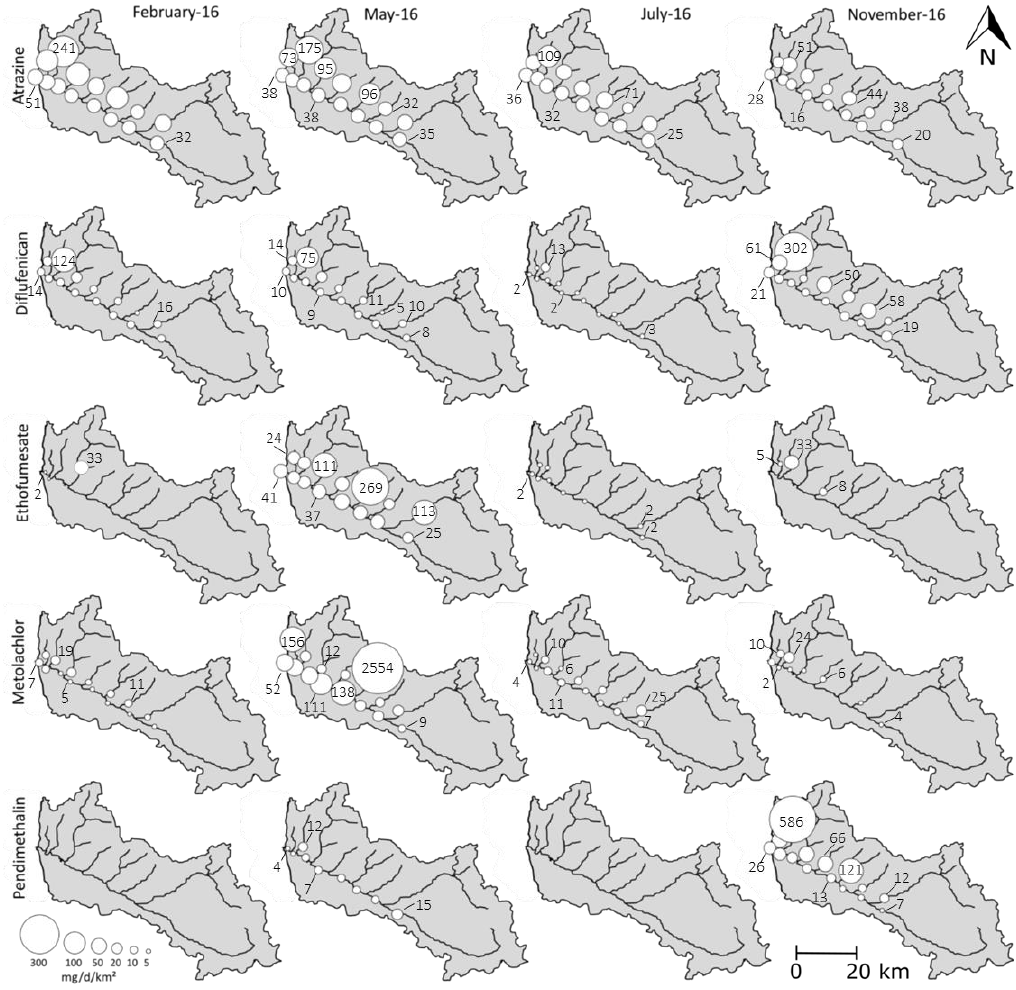
− 1 km − 2 ; see also Table